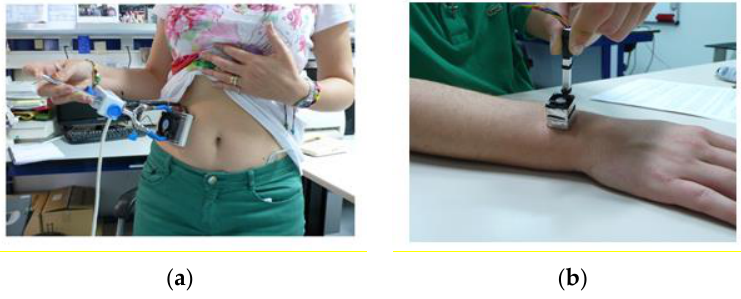
Figure 9. Placing the S36 ( a ) and S4 ( b ) sensors on the human body.